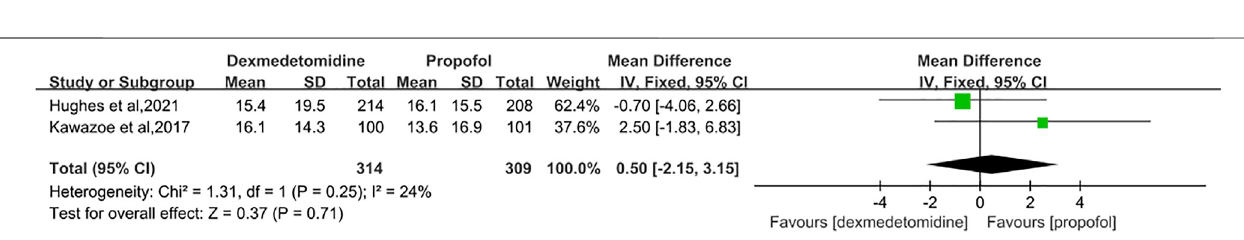
FIGURE 5 | Forest plot comparing ventilator-free days between two